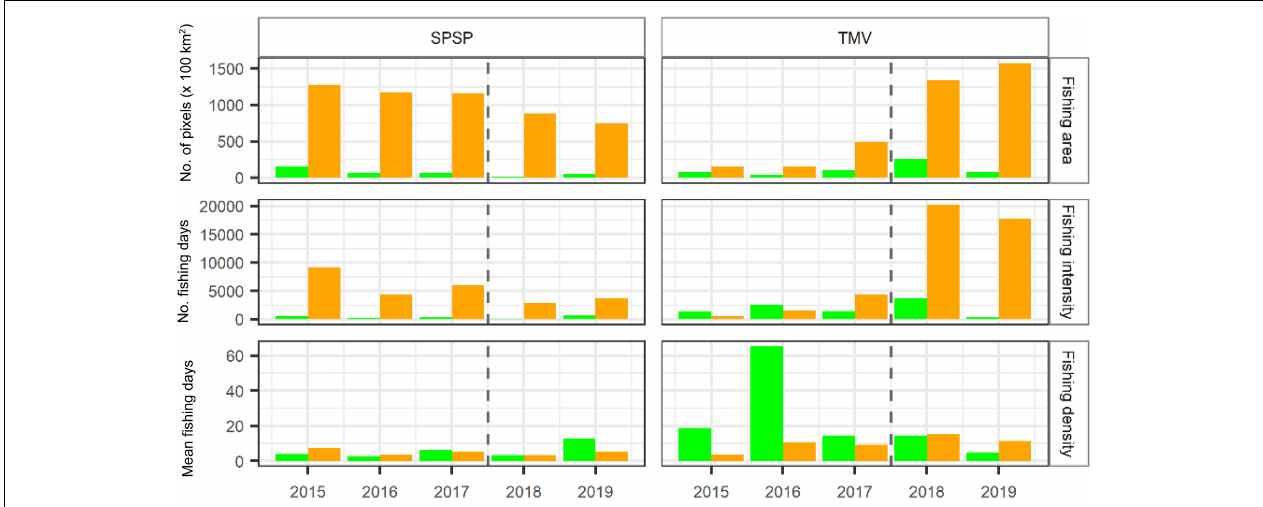
FIGURE 4 | Summaries of fishing pressure on each large-scale MPA off Brazil (green for no-take and orange for multiple-use ones) across 2015–2019 in terms of fishing area, intensity, and density. Panels on the right are results for the TMV region and on the left for the SPSP region. The dashed line indicates the time of MPA